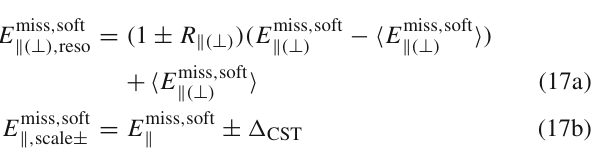
longitudinal (perpendicular) directions. The mean values of parameters are denoted using angled brackets. The (cid:12) CST is the scale uncertainty, and the R (cid:10) ( ⊥ ) is the fractional resolu- tion uncertainty taken from the lower portion of Fig. 20b. and the average number of Both depend on the p hard T